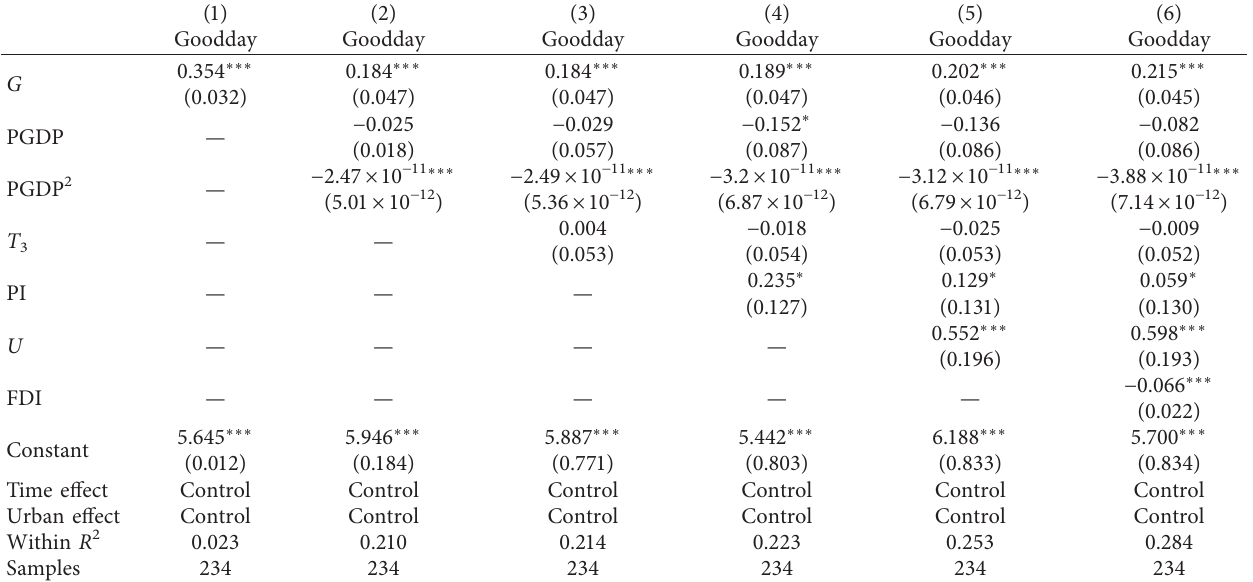
Table 2: Basic regression